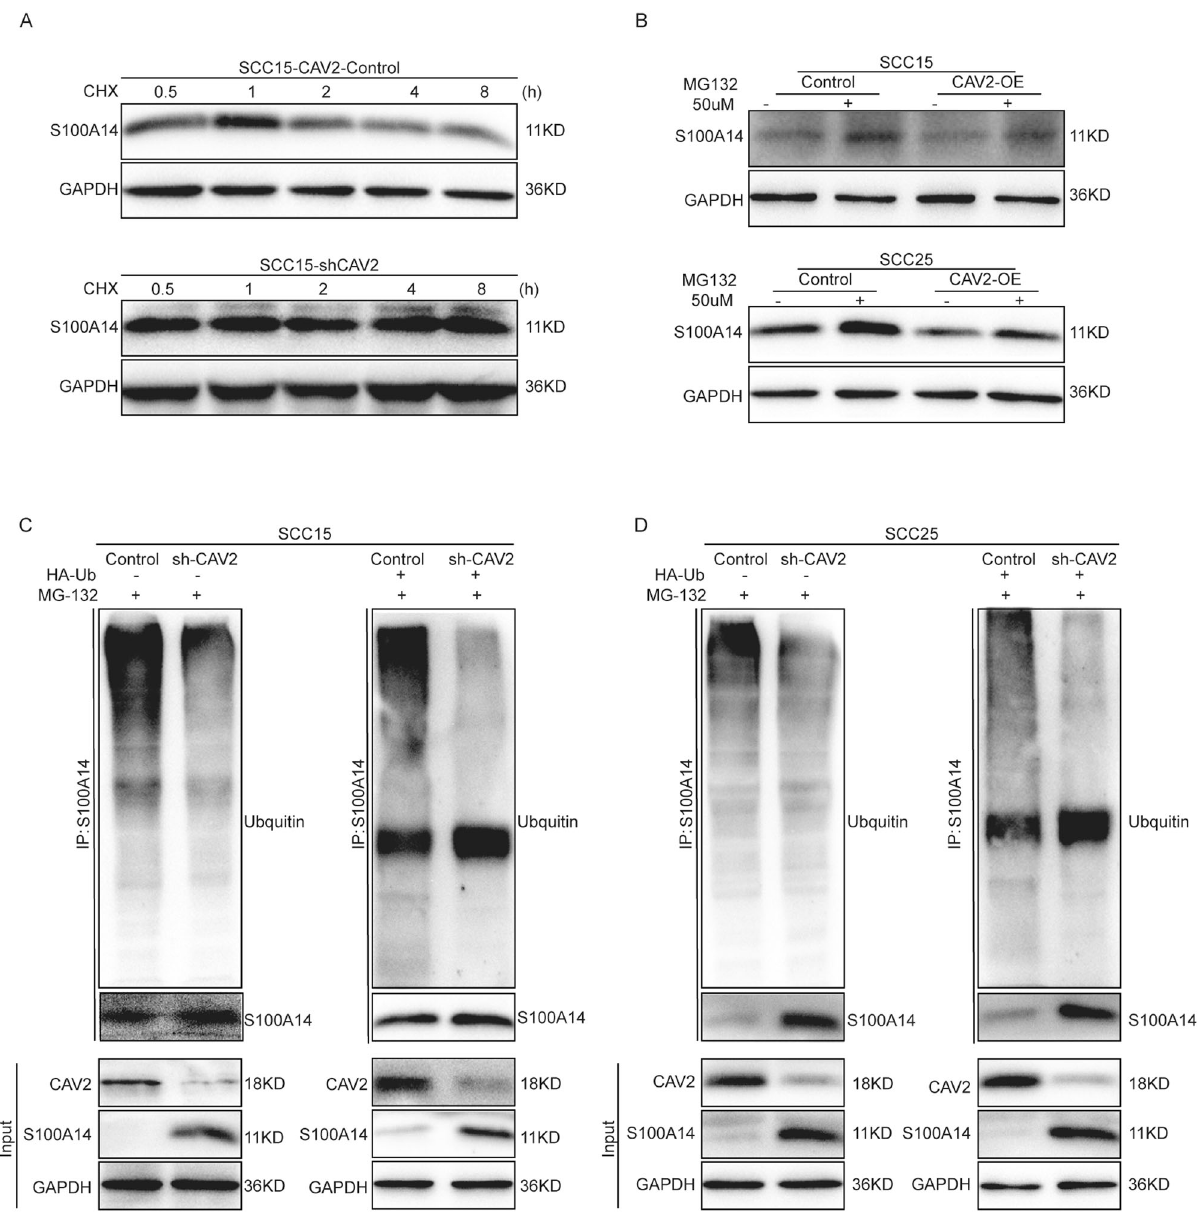
Fig. 5 CAV2 promotes ubiquitin-proteasome-mediated degradation of S100A14. A S100A14 protein levels were determined by immunoblotting in vector control or shCAV2 SCC15 cells in the presence of 50 µg/mL CHX for the indicated time periods. B S100A14 protein levels were determined by immunoblotting in control and CAV2-overexpressing SCC15 and SCC25 cells in the presence or absence of the proteasome inhibitor MG132 (50 μ M). C , D Ubiquitin-S100A14 was detected by immunoprecipitation (IP) using anti-S100A14 with a subsequent immunoblot assay with anti-ubiquitin antibody in control and shCAV2 SCC15 and SCC25 cells. HNSCC cells were transfected with or without an HA-Ub expression